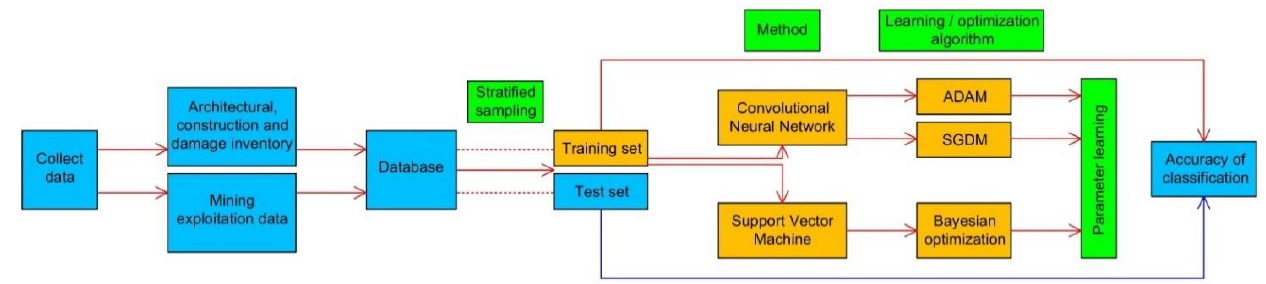
Figure 1. Conceptual diagram showing the individual stages of the analyses carried out.